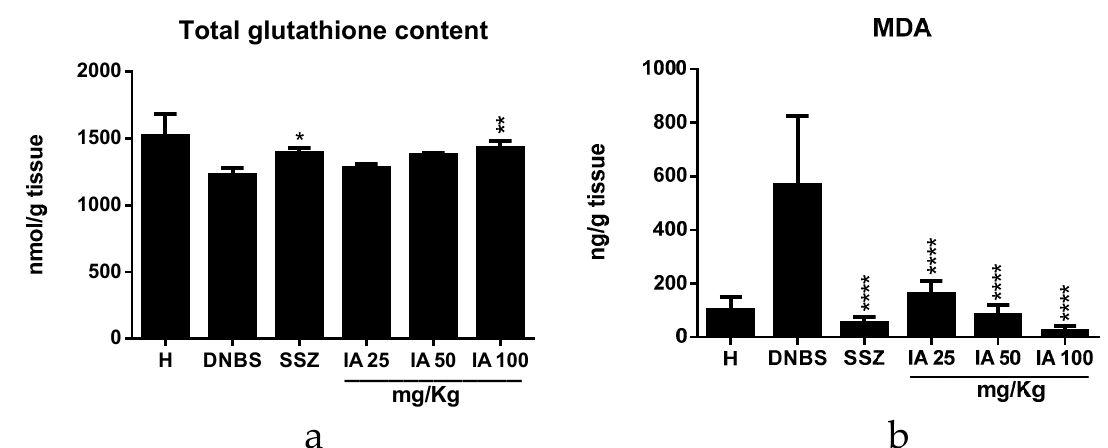
Figure 4. Effect of I. asarifolia (IA) aqueous extract at doses of 25, 50, and 100 mg/kg and sulfasalazine (SSZ) at 250 mg/kg on colonic oxidative stress by total glutathione content ( a ) and malondialdehyde (MDA) levels ( b ) in the experimental trial of acute colitis induced by 2,4-dinitrobenzene sulphonic acid (DNBS) in rats. H, Healthy group; DNBS, DNBS group; SSZ, Sulfasalazine group; and 25, 50, and 100 mg/kg doses of IA. Data are expressed as mean ± SEM, ( n = 8). Statistical differences * p < 0.05, ** p < 0.01, *** p < 0.001 and **** p < 0.0001 of treatments vs DNBS control were presented.